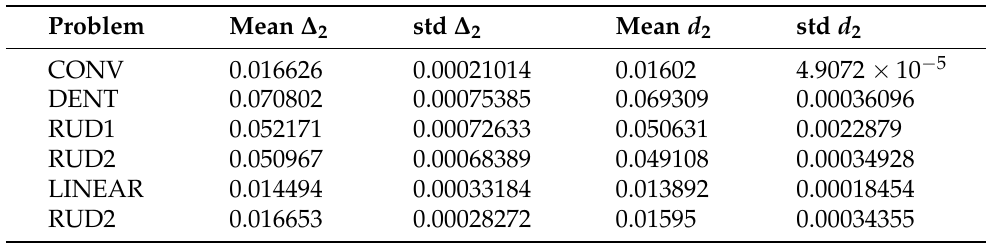
Table A2. Averaged Hausdorff distances ∆ 2 and approximations d 2 computed by ArchiveUpdateHD for the six bi-objective